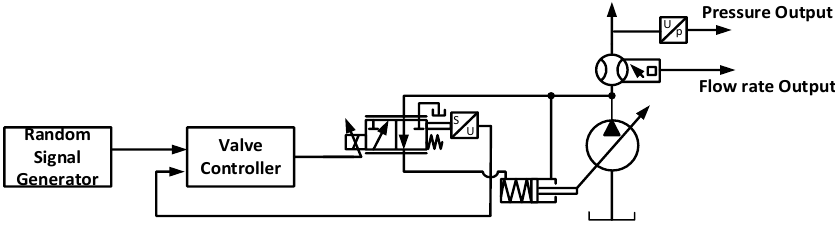
Figure 4. Structure scheme of open loop identification experiment.